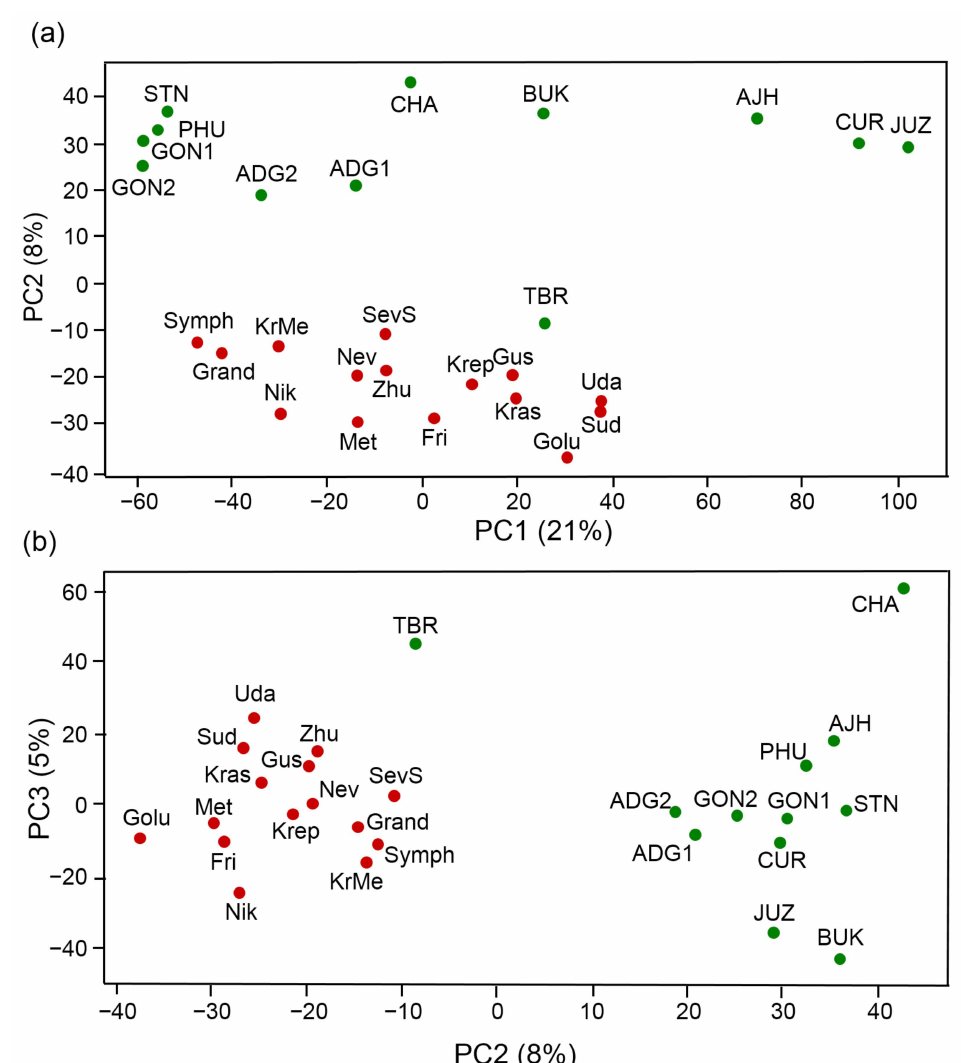
Figure 5. Principal component analysis diagrams for potato genotypes based on the CNV similarity for DM1-3 v4.03 protein-coding genes. ( a ) PCA plot for PC1 ( X -axis) and PC2 ( Y -axis) components; ( b ) PCA plot for PC2 ( X -axis) and PC3 ( Y -axis) components. Explained percentage of variance shown in parentheses. Selected for this study Russian potato cultivars shown as red dots, and South American accessions shown as green dots. See Table 1 for abbreviation of the names of 15 Russian cultivars and Table 2 for abbreviation of the names of South American